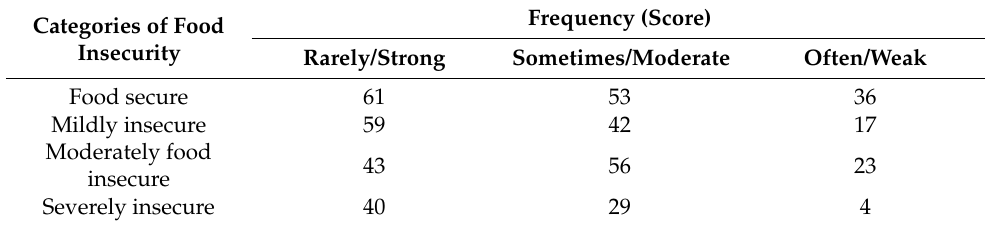
Figure 7. Interpreting resilience scores. Table 6. Household resilience levels to food